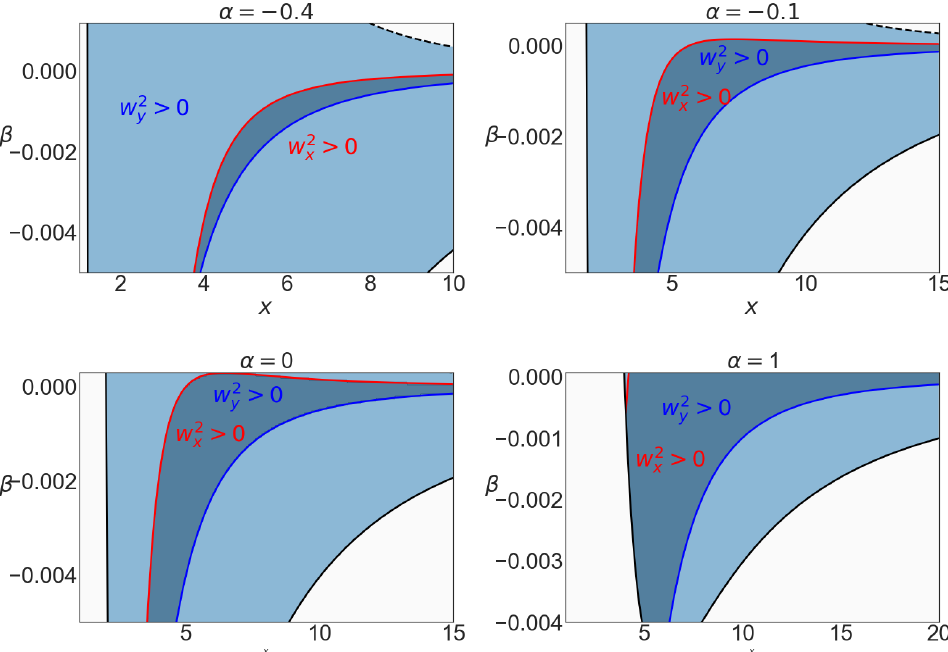
Figure 5. Stability of the timelike circular orbits in the ( x , β )-plane. Timelike circular orbit exists in the light blue area. This region is bounded by the thick dark line ( 2 S − x = 0 ) and the dashed line ( S = 0 ) . The blue curve represents w 2 = 0 and the red one w 2 = 0. The blue-gray region shows the y x stability domain with respect to chosen